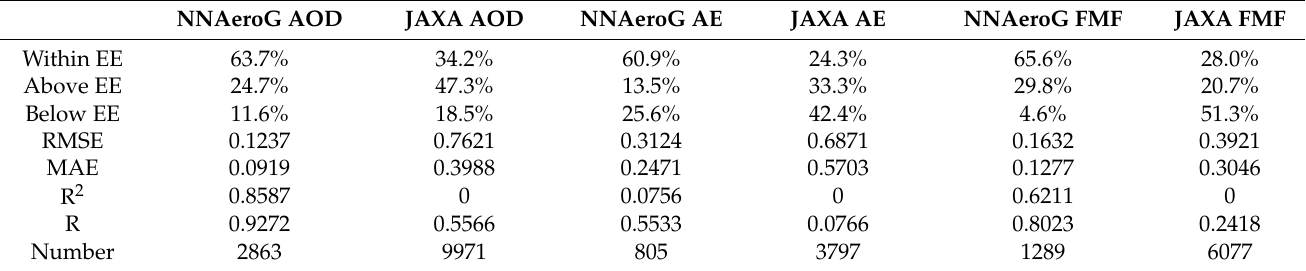
Figure 5. Scatterplots of Himawari-8/AHI retrieved AOD, AE and FMF versus AERONET and SONET reference data. The left column shows scatterplots for NNAeroG products over the training sites, i.e., versus the same data that were used for training the NNM. The middle column shows scatterplots for NNAeroG products over sites that were not used in the NNM training. Scatterplots for the JAXA products are presented in the right column. The red lines are the EE envelopes for AOD, AE and FMF of ± (0.05 + 15%), ± 25% and ± 25%, respectively. Table 3. Statistical metrics of the evaluation of the aerosol parameters retrieved using NNAeroG algorithm and the JAXA operational data versus AERONET and SONET reference